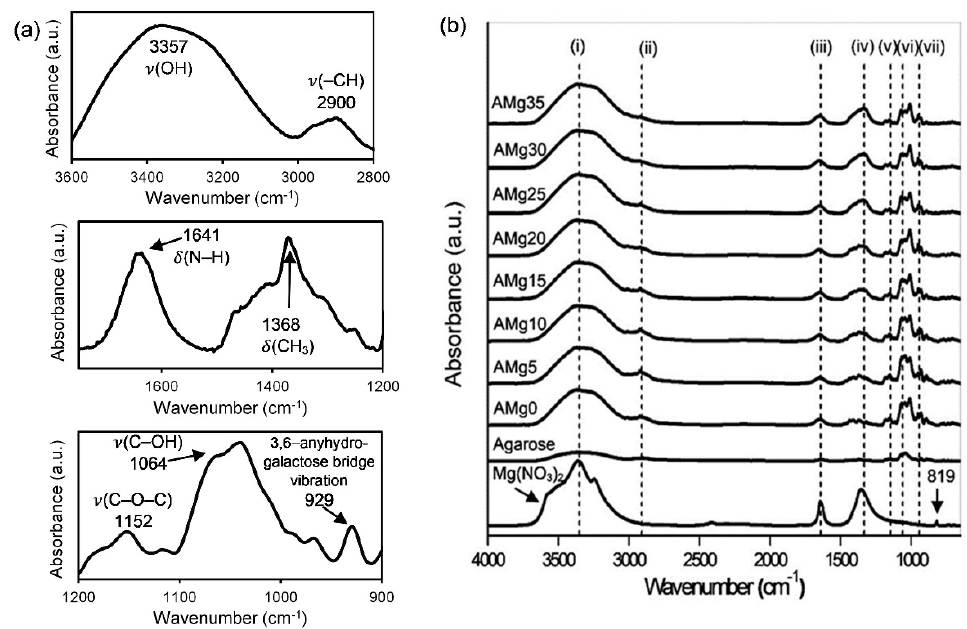
Figure 4. FTIR spectra of ( a ) pure agarose in region 3600–2800 cm − 1 , 1750–1200 cm − 1 and 1200–900 cm − 1 and ( b ) Mg(NO 3 ) 2 , pure agarose and agarose–Mg(NO 3 ) 2 polymer electrolyte film